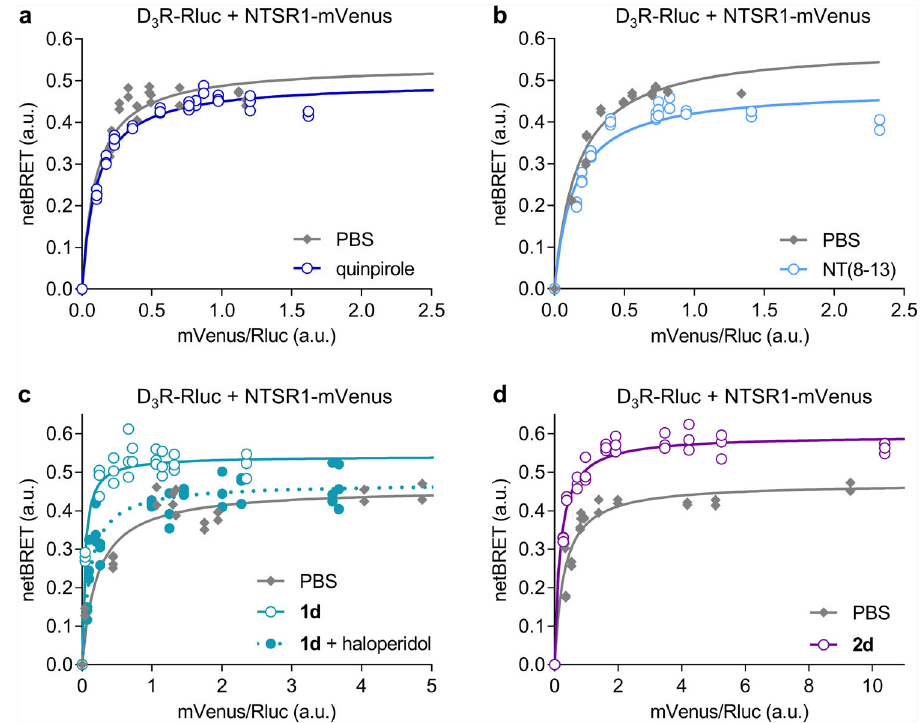
Fig. 3 BRET Saturation curves are in fl uenced by mono- and bivalent ligands. a , b The hyperbolic BRET saturation curve for the coexpression of D 3 R-Rluc and NTSR1-mVenus is indicative of a speci fi c protein – protein interaction. Stimulation of either receptor with monovalent agonists (1 µ M) reduces BRET max . c , d The presence of bivalent ligands (10 nM) strongly increases BRET max and slightly reduces BRET 50 . Preincubation with haloperidol (10 µ M, 30 min) abolishes the effect. Data show individual replicates for a single representative experiment of at least three independent repetitions.